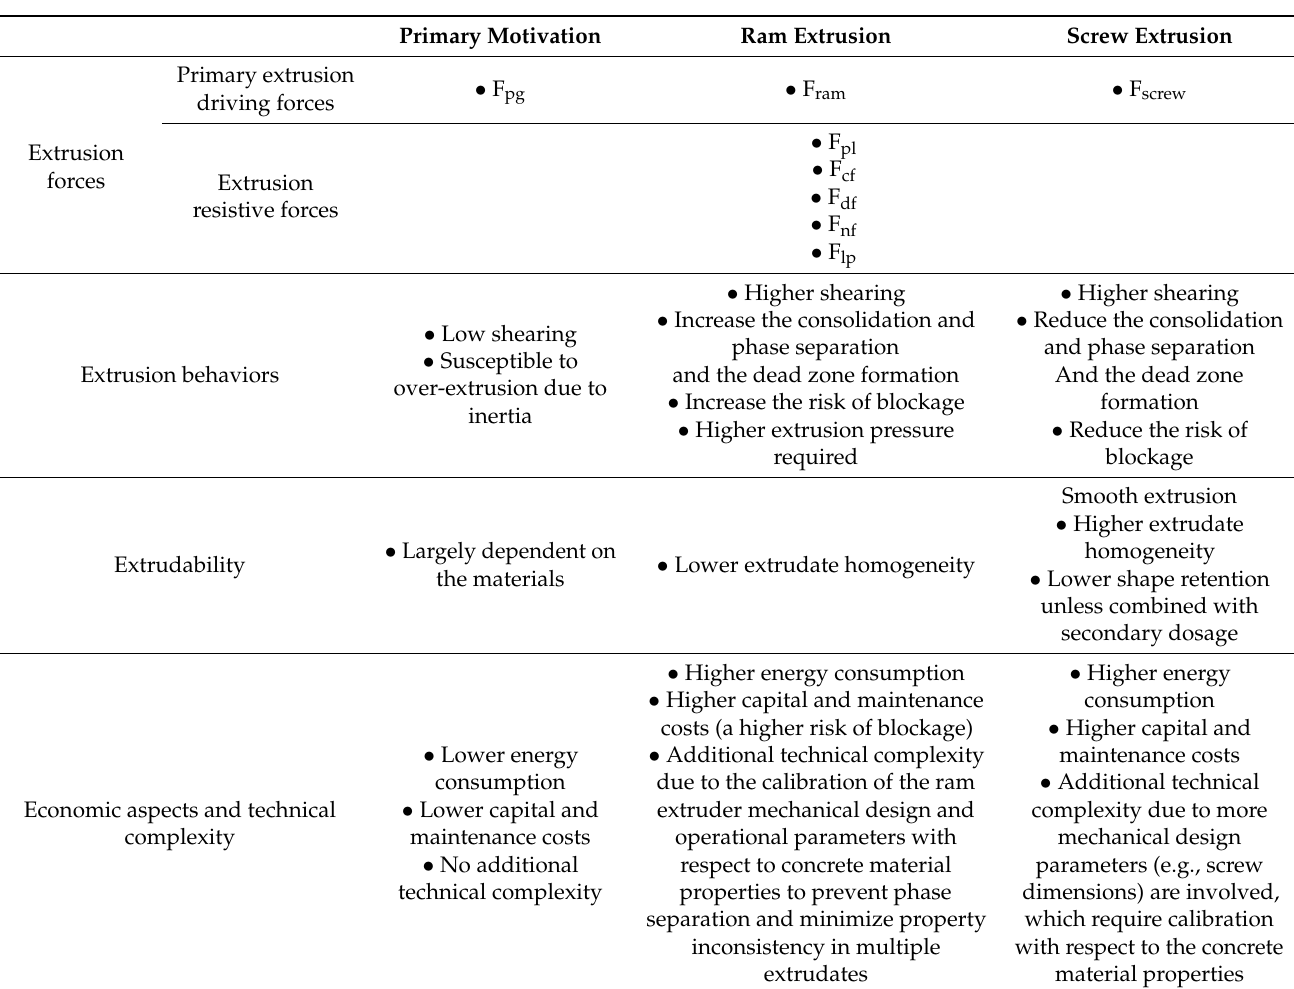
Table 2. The effects of extruder mechanisms on the extrusion forces, extrusion behaviors, extrudability and economic aspects and technical complexity based on the same material design and operational